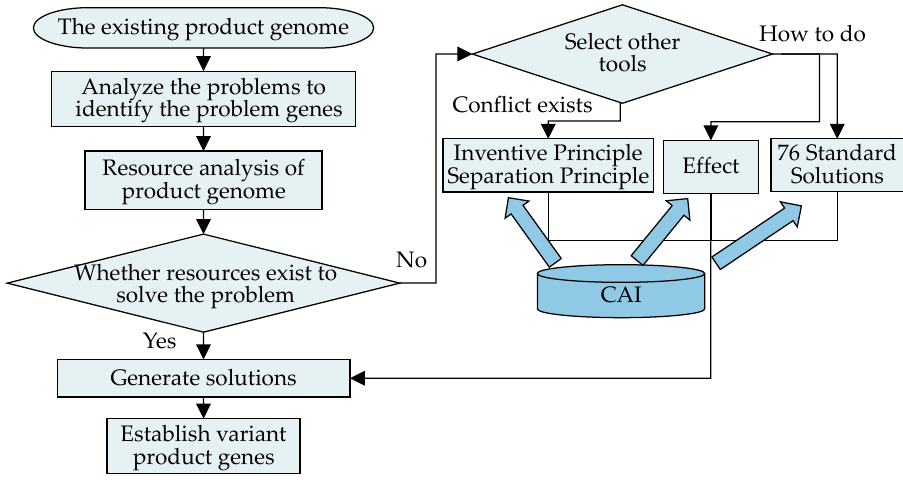
Figure 12. A variation process model of a product gene based on TRIZ.